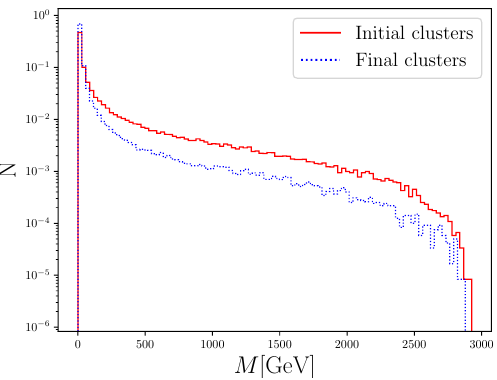
Figure 4 . Invariant cluster mass distribution before and after colour reconnection for UA5 kine- matics with random initial colour connections.